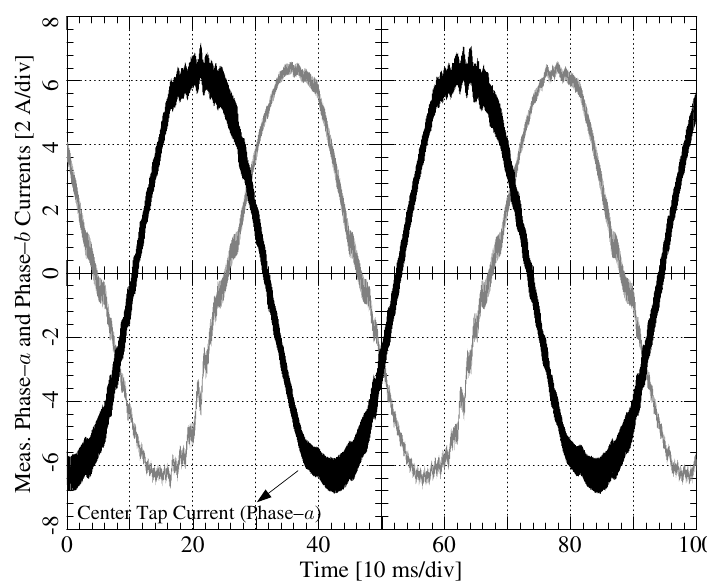
Figure 10. Experimental steady-state (360 r/min) phase- a and – b current waveforms under full load (2 N·m) while R s increased by 82.35% and λ f is decreased by 40% with K = 5 (high). If the PM rotor flux linkage λ f is estimated using observer like methods without estimating the remaining parameters ( R s and L s ) almost simultaneously, the correct PM rotor flux linkage λ f value